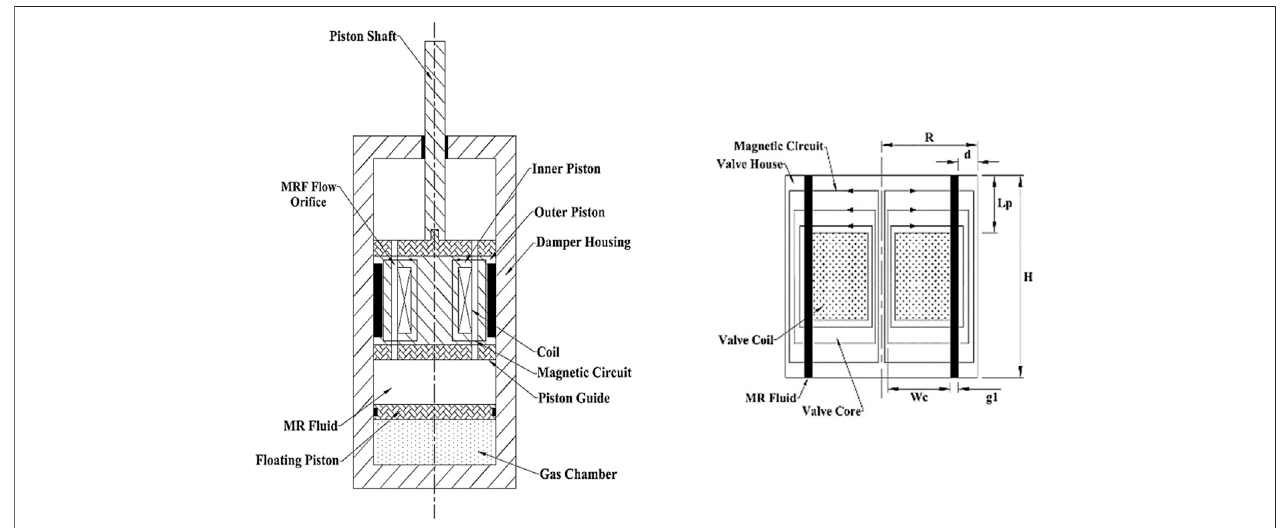
FIGURE 3 | Diagram of MRD and the MR valve (Seid et al.,